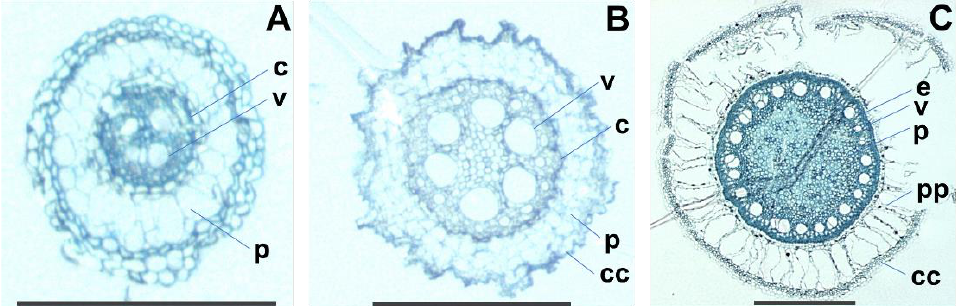
Figure 3. Toluidine blue-stained cross-sections of vetiver root. Plants were grown ( A ) in vitro, ( B ) in HPA, or ( C ) in potting soil. Observations were made using a photonic microscope. Bars represent 250 μm. c: central cylinder; cc: cortical cells; e: endoderm; p: parenchyma; pp: palissadic parenchyma; v: xylem